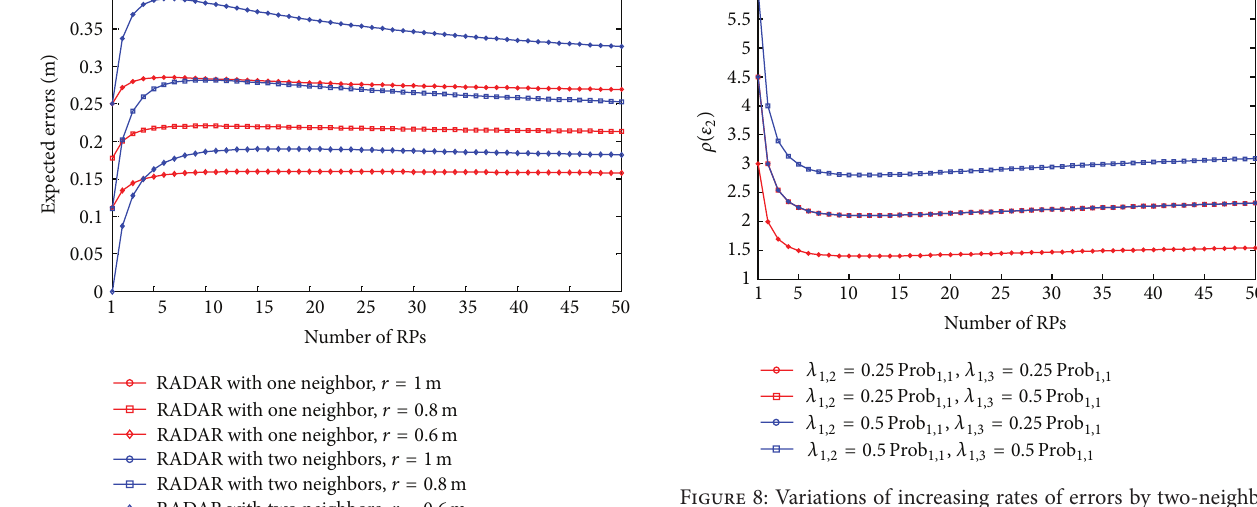
Figure 8: Variations of increasing rates of errors by two-neighbor matching ( 𝑟 = 1